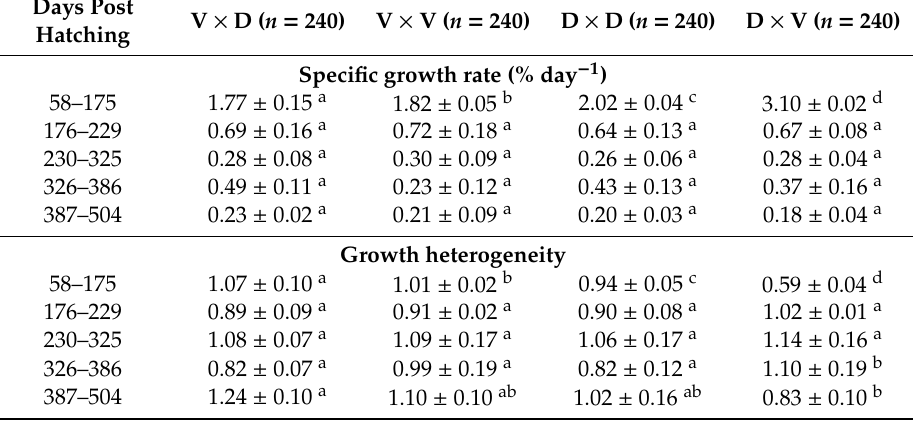
Table 5. Specific growth rate and growth heterogeneity (mean ± SD) of the hybrid and purebred crosses of sterlet at 58, 175, 229, 325, 386, and 504 dph. Di ff erent superscripts within a row indicate significant di ff erences.